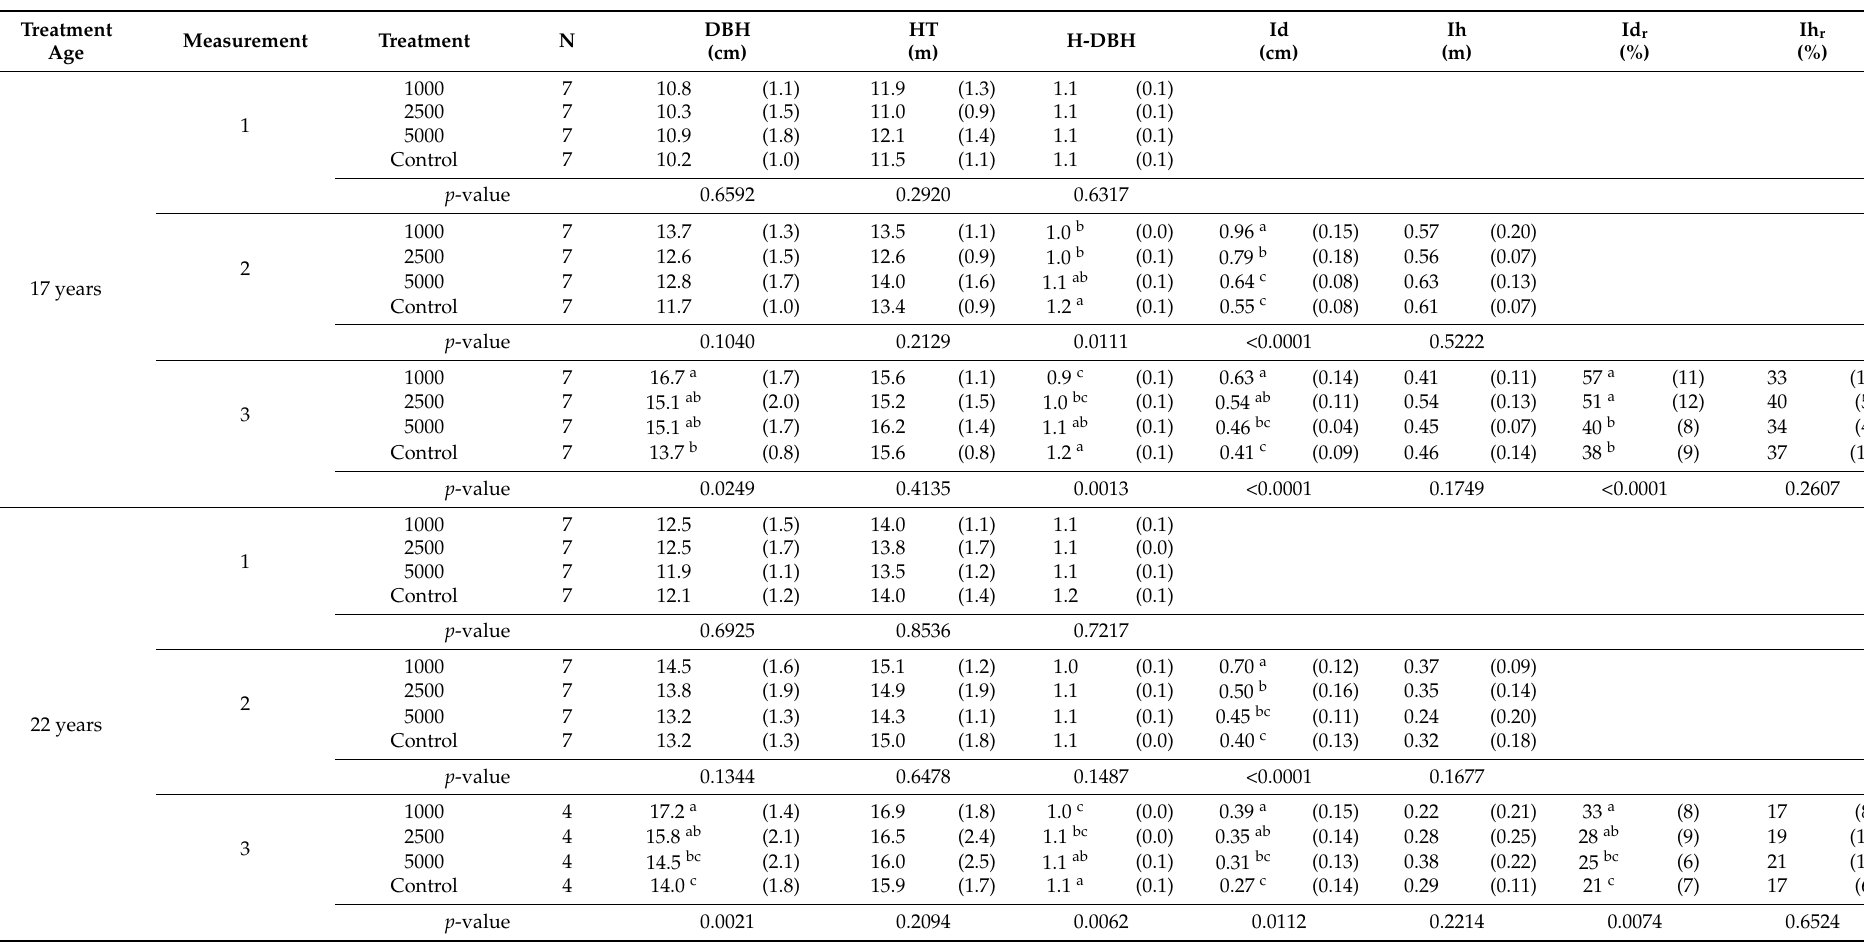
Table 2. Treatment means and standard deviations (shown in parentheses) from post-treatment measurements of dominant (200 stems ha − 1 top diameter at breast height, 1.3 m (DBH) aspen) aspen trees. p -values are from mixed-model ANOVA; numbers with different letters within each measurement and treatment age, show significant differences between treatments based on Tukey’s post-hoc test with Bonferroni’s adjustment. N—sample size; DBH—mean diameter at breast height (1.3 m); HT—mean height; H-DBH—mean height-to-DBH ratio; Id—mean periodic